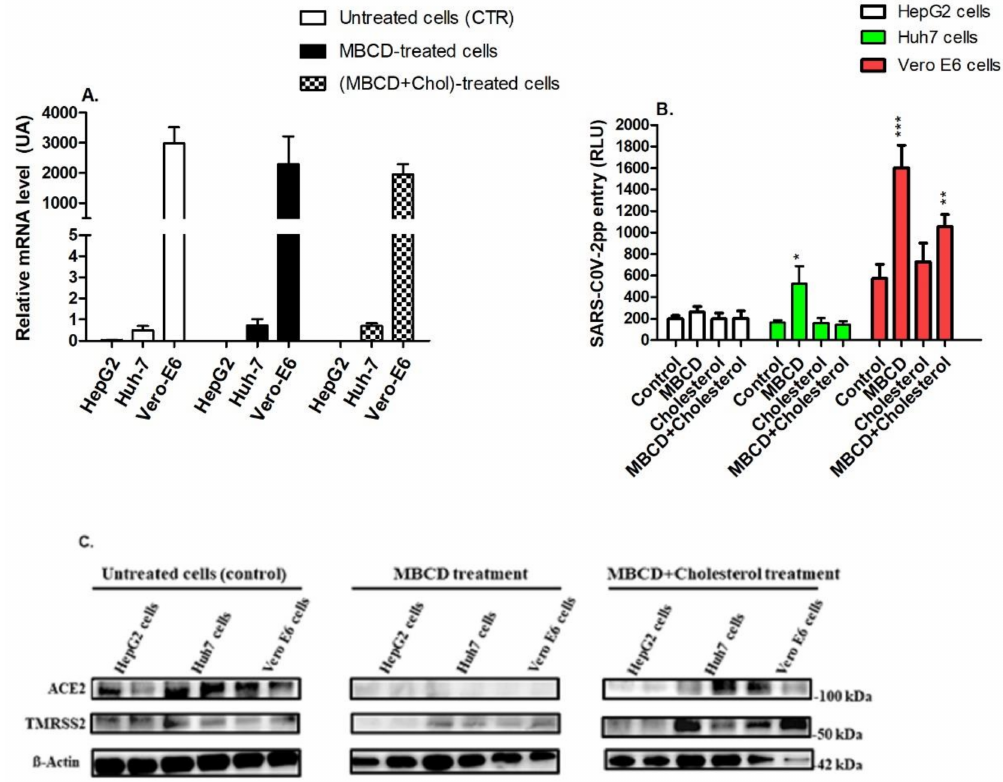
Figure 4. Depletion of cellular cholesterol alters raft-associated receptors involved in SARS-CoV-2pp entry. Different cells lines were treated with M β CD or M β CD-cholesterol complexes for 1h prior to SARS-CoV-2pp infection. At 48 h p.i., cells were used for the total RNA extraction to measure the expression of the ACE receptor by qRT-PCR ( A ). In separate experiments, cells were used to measure SARS-CoV-2pp entry using a luciferase assay ( B ) and to determine the protein expression levels of the ACE2 receptor and TMPRSS by Western blotting ( C ). Values are plotted as the mean ± SD (N = 3). p values were calculated using a two-tailed Student t -test. * p < 0.05, ** p < 0.001, and *** p < 0.0001 vs. control